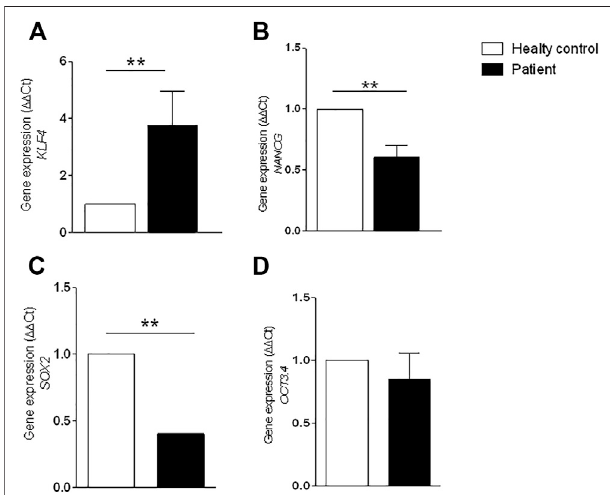
FIGURE 5 | Gene expression by RT-PCR. Expression was analyzed usingGAPDHreferencegeneandresultswerenormalizedthroughthecontrol samples. (A) Increased expression of KLF4 gene (** p = 0.0016); (B) reduced expression of NANOG gene (** p = 0.0016); (C) reduced expression of SOX2 gene (** p = 0.0014); (D) reduced expression of POU5F1 (OCT3.4) gene. Error bars represent SD. Statistical signi fi cance was determined by Student ’ s t test. Data represent triplicate of 2 independent experiments.